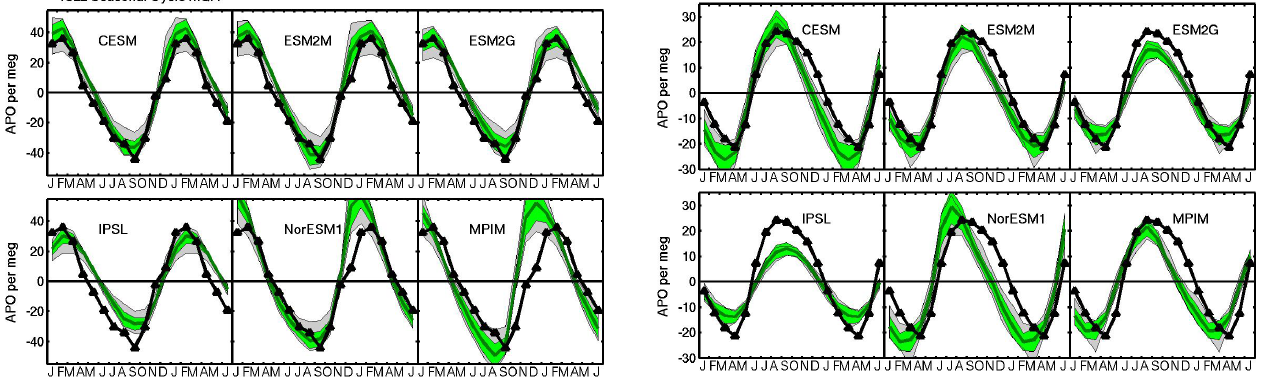
Figure 2c. Results at Macquarie Island (54.5 ◦ S, 159 ◦ E), compared to PU observations.